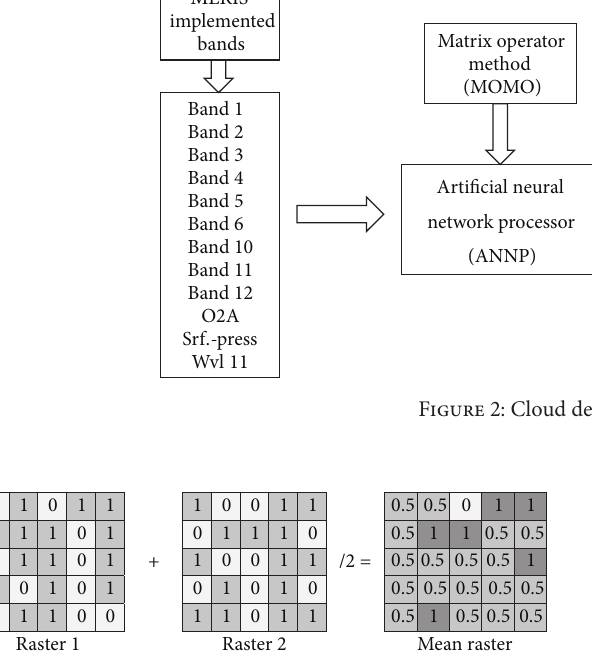
Figure 3: Mean command